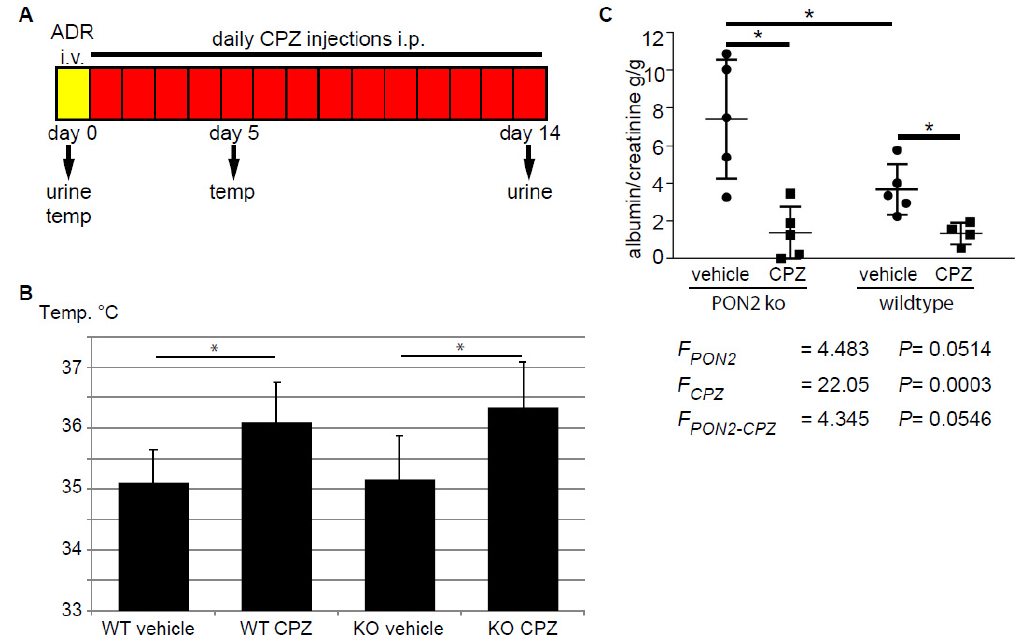
Figure 5. Daily administration of capsazepine reduces albuminuria in PON2-deficient and PON2- proficient mice during adriamycin-induced nephrosis. ( A ) Schematic representation of the in vivo protocol. After i.v. injection of adriamycin (ADR), mice were treated for 14 days with daily i.p. administration of capsazepine. Urine samples were collected on days 0 and 14 and body temperature was measured on days 0 and 5. ( B ) Body temperature was significantly increased in capsazepine-treated animals, measured after 5 days. Asterisks indicate * p < 0.05 by unpaired t -test. ( C ) Urine albumin/creatinine ratio at day 14 was significantly reduced in capsazepine-treated mice compared to vehicle-treated controls. This occurred in both PON2-proficient and PON2-deficient animals. Asterisks indicate * p < 0.05 by unpaired t -test. 2-way ANOVA shows differences of means for capsazepine treatment (F CPZ ), a strong trend toward differences of means for PON2 (F PON2 ), and an interaction effect of both categorical variables (F PON2-CPZ ).